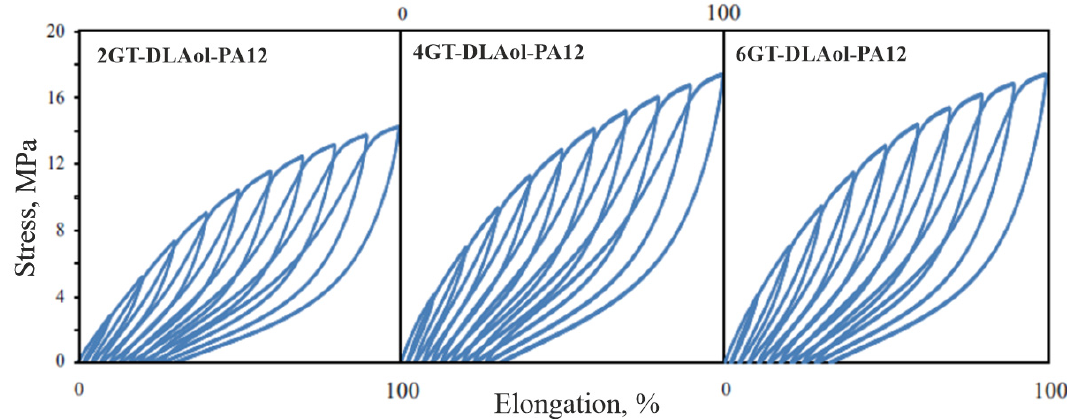
Figure 17. Mechanical hysteresis loops with elongation growing by 10% of the terpoly(ester-aliphatic-amide) of series II.